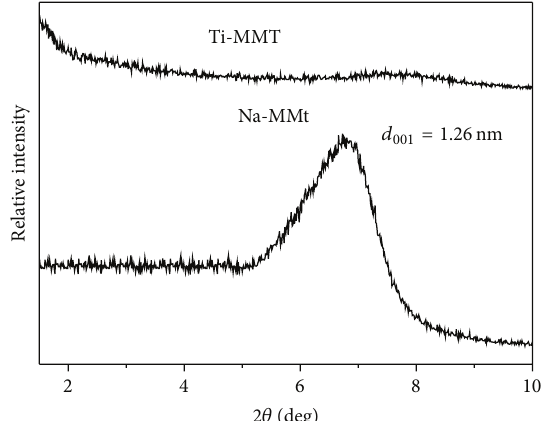
Figure 2: Small angle XRD spectrums of Na-MMT and Ti-MMT (1 ∘ –10 ∘